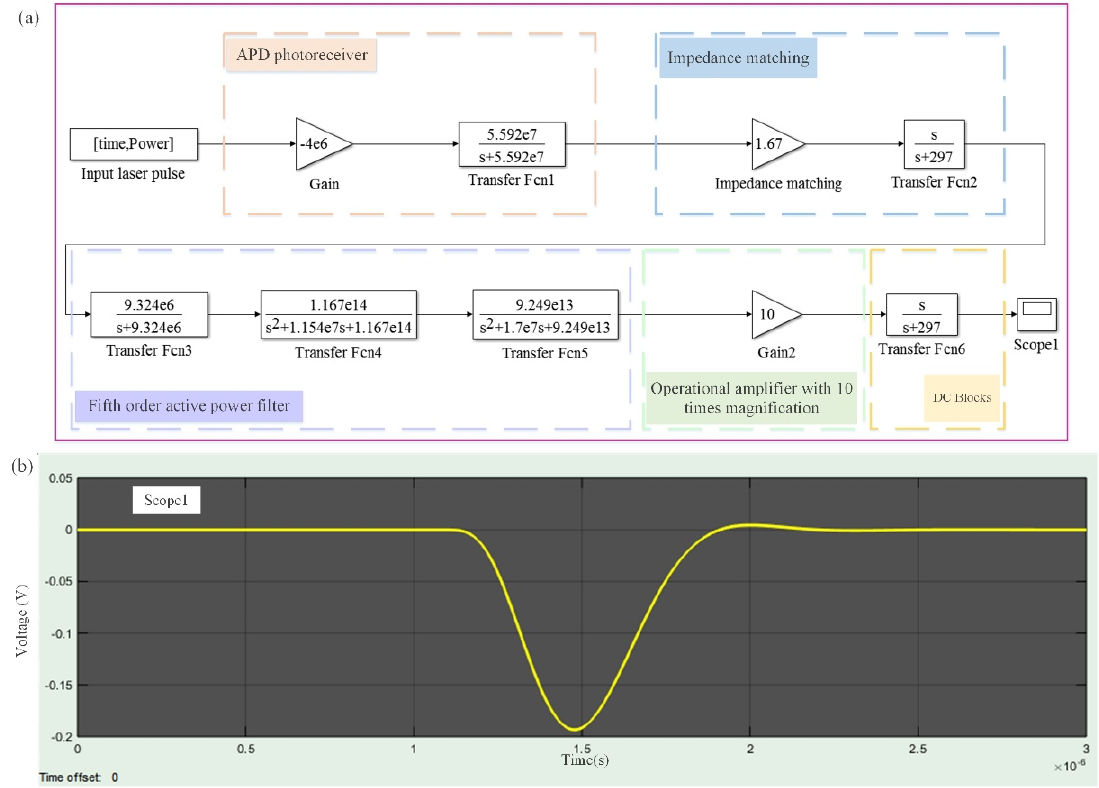
Figure 20. ( a ) The transfer model of the whole detector established by SIMULINK. ( b ) The output waveform of the signal output from the transfer model.